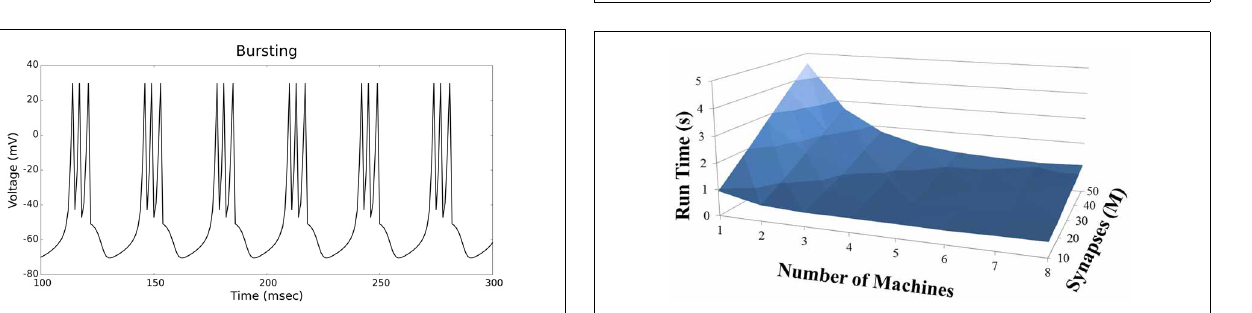
FIGURE 10 | LIF neuron model: 1s simulation.